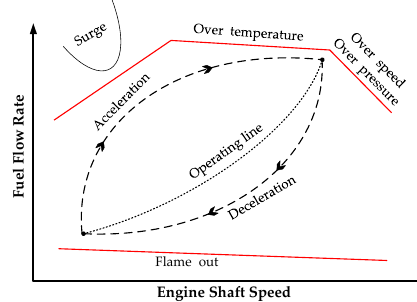
Figure 5. Operation limits for engine control.